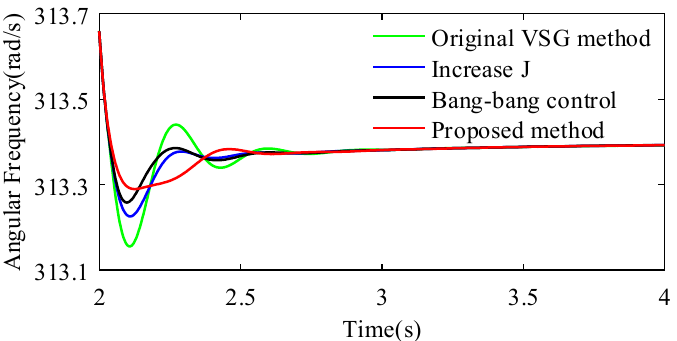
Figure 16. The simulation result of SG angular frequency with three methods.